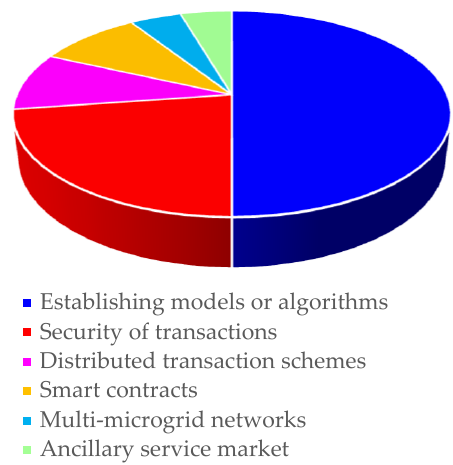
Figure 4. Application situation of blockchain in microgrid.